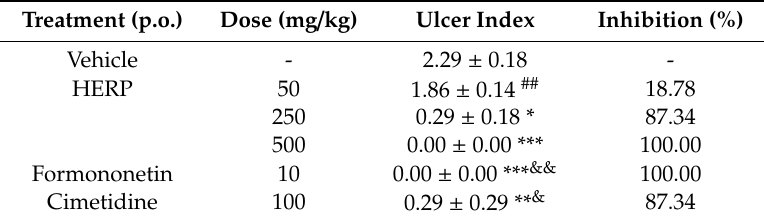
Table 2. E ff ects of HERP and formononetin on indomethacin-induced ulcers in rats. Treatment (p.o.)